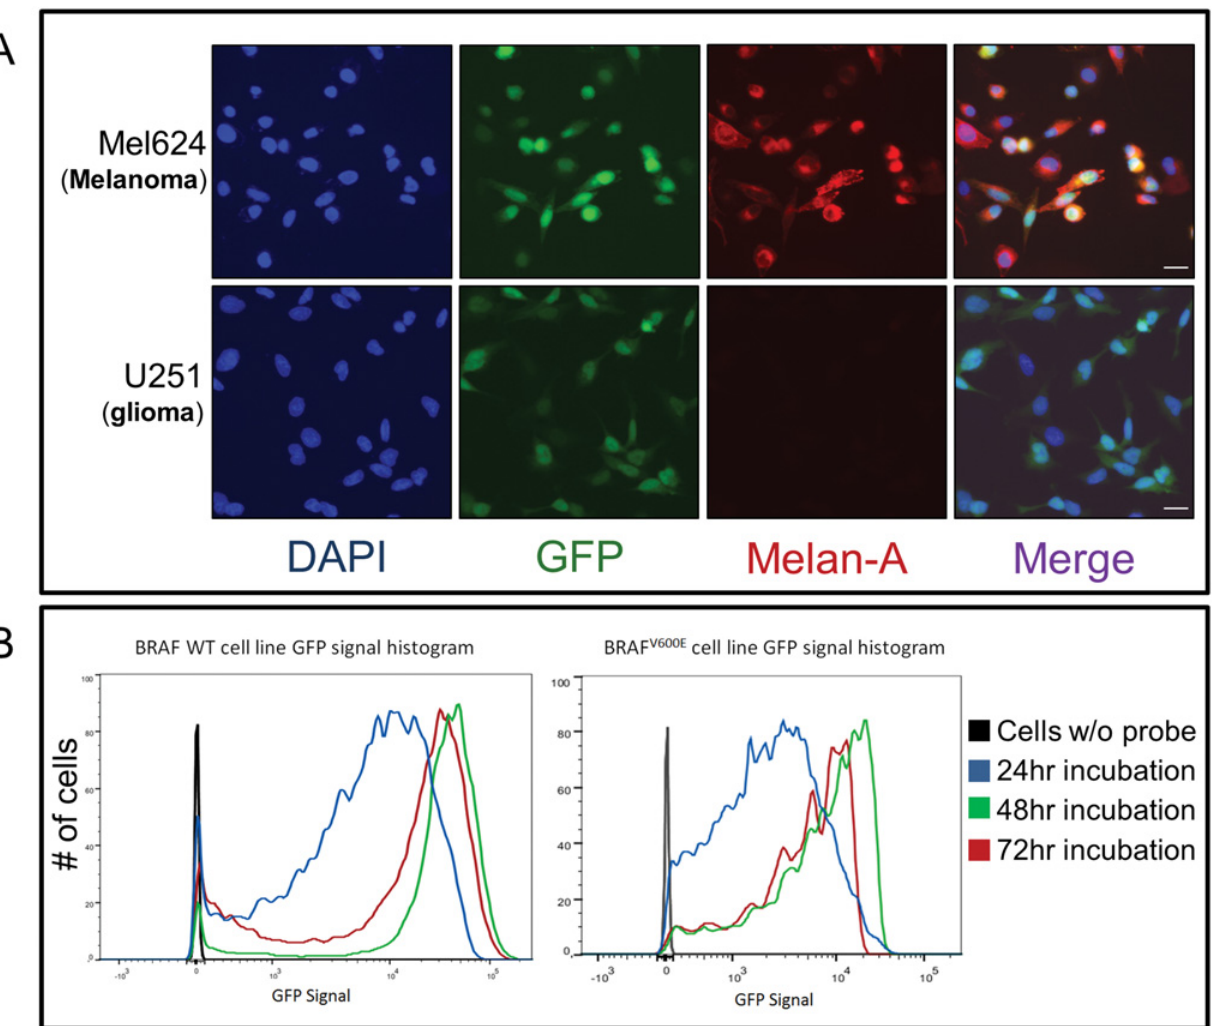
Fig 1. Pre-clinical characterization of the viral probe ’ s efficacy in melanoma cells. (A) Melanoma and glioma cells (Mel624 and U251, respectively, are shown in the top and bottom rows as representative examples) were incubated with the probe, followed by immunofluorescence staining for Melan-A. Robust GFP expression indicated the efficacy of the probe for melanoma was comparable to that for glioma. The identity of melanoma cells is confirmed by Melan-A expression that coincided with GFP. Each row shows the same cells, with DAPI as a nuclear stain in the left-most panel, and the rightmost panel (Merge) show merged images of all three fluorescent channels. Bar, 30 um. (B) Flow cytometry analysis of BRAF WT (MeWo) and BRAF mutated (Mel624) cells indicated that for both cell lines, GFP signal peaked after 48 hours of exposure to the viral probe, with no further increase after 72 hours.